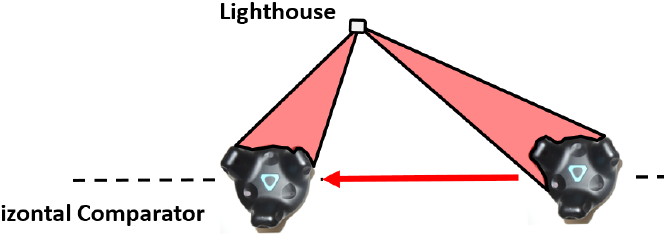
Figure 13. Visibility of different IR diodes as the tracker moves along the horizontal